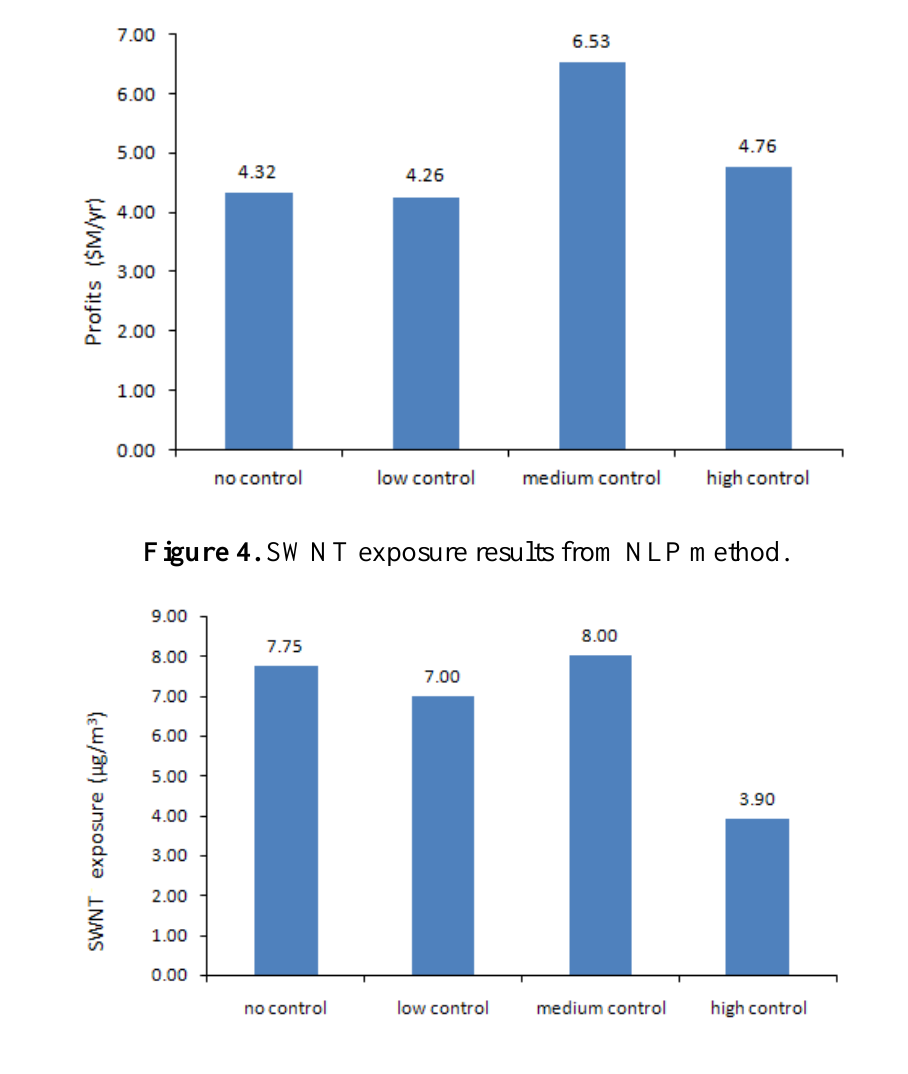
Figure 3. The annual net profits calculated from NLP method.